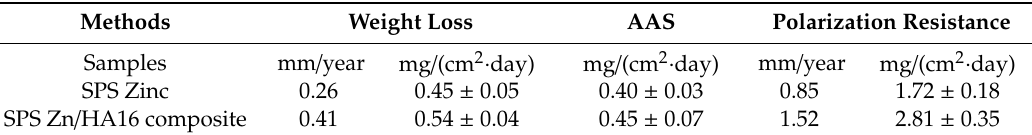
Table 4. Corrosion rates evaluated from the weight loss, ion release and polarization resistance Corrosion rates evaluated from the weight loss, ion release and polarization measurement. resistance measurement.